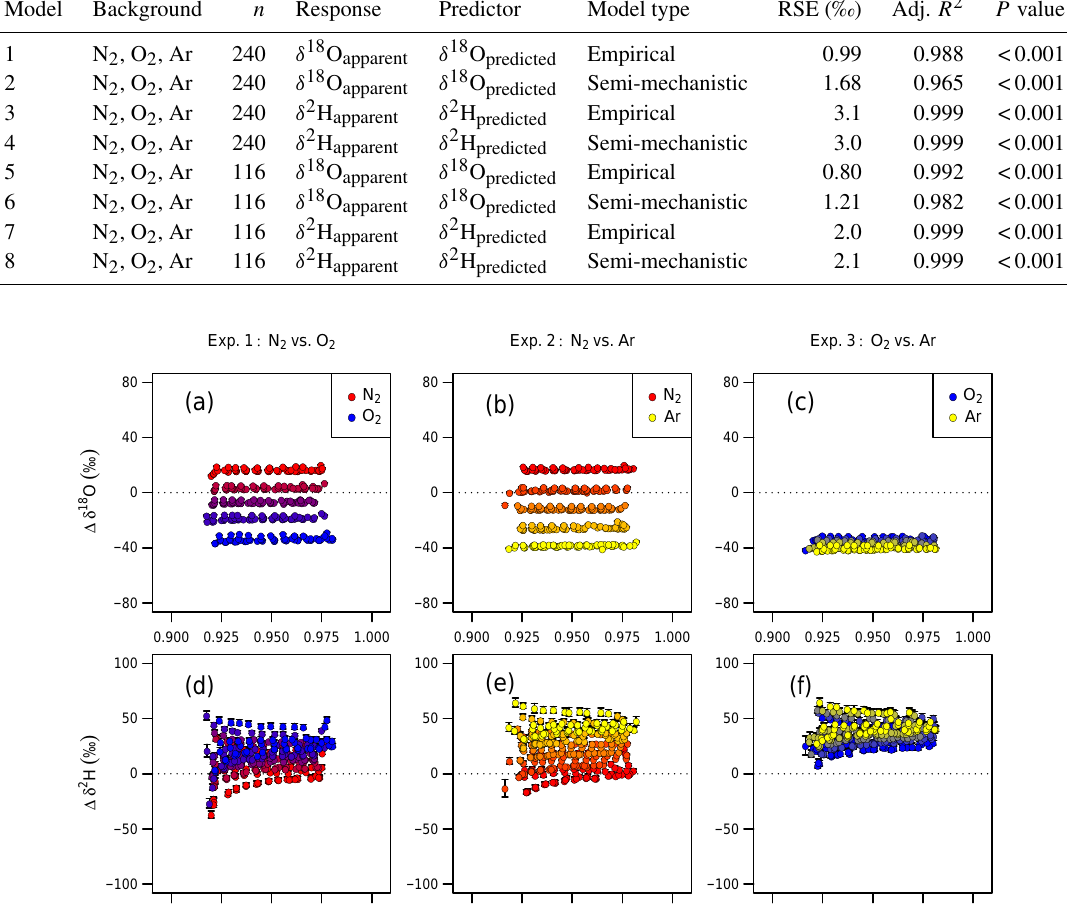
Table 5. Comparison of empirical and semi-mechanistic models for predicting δ 18 O and δ 2 H values in a ternary mixture of N 2 , O 2 , and Ar. Overall model fit is summarized with the residual standard error (RSE), adjusted R 2 , and P value.